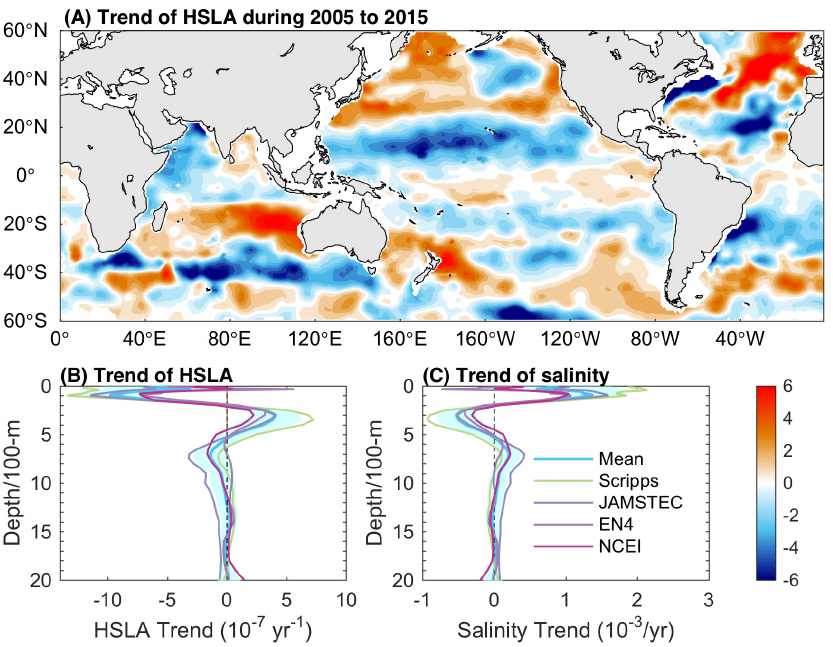
Figure 3. Trend of HSLA over 2005–2015 based on the ensemble mean of all the datasets. ( A ) Geographically pattern, unit: mm/yr; ( B ) Vertically trend in global mean perspective with standard deviation patched; ( C ) the same as ( B ), but with salinity instead.